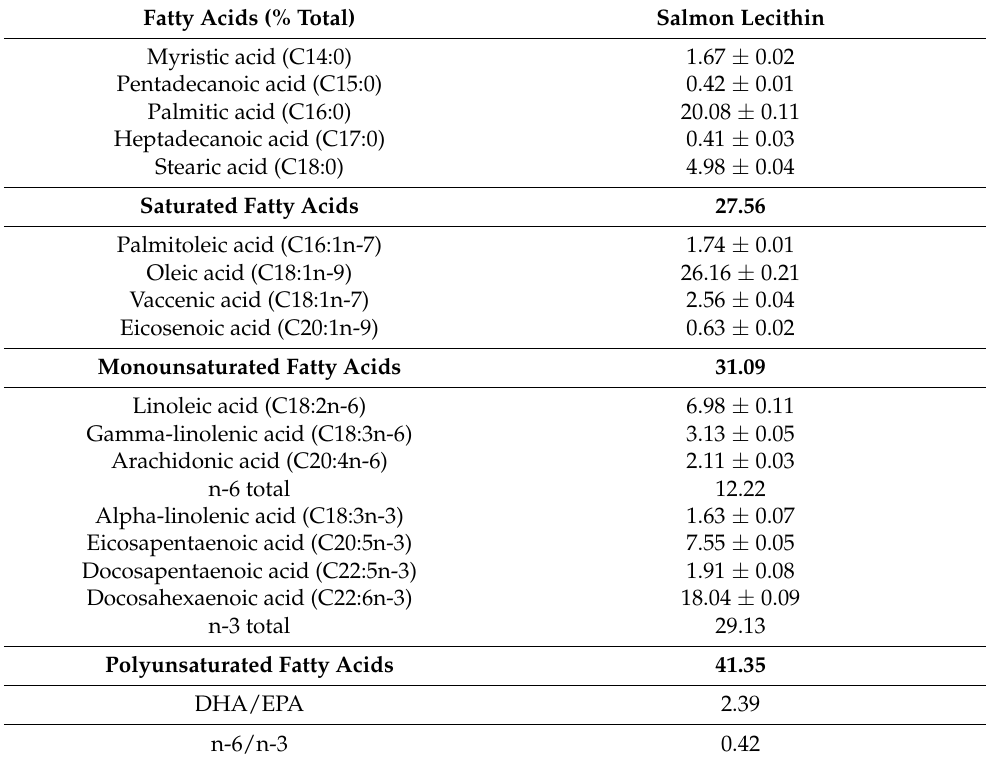
Table 1. Fatty acid composition of